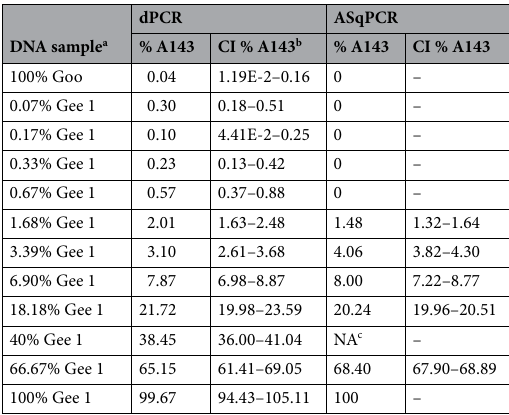
Table 4. Sensitivity of the G143A dPCR and ASqPCR assays on a mixture of total DNA of leaves infected with mutant (A143) and wild type (G143) Blumeria graminis f. sp. tritici . a Goo Goomalling (G143), Gee1 Geelong 1 (A143). b CI 95% confidence interval. c This concentration was not tested with ASqPCR.